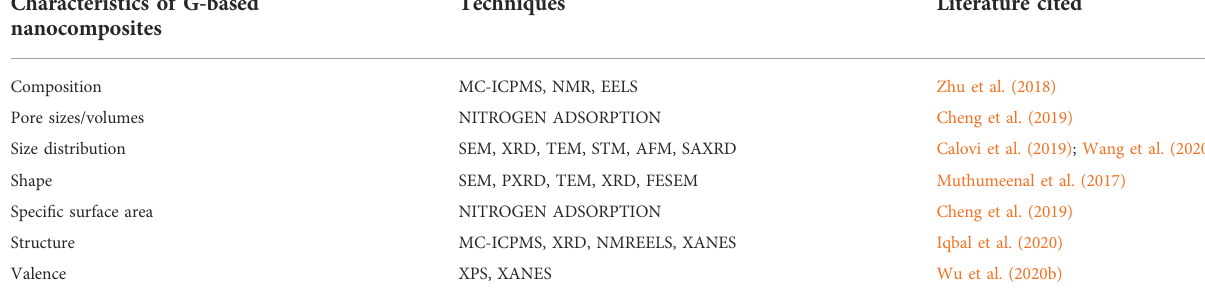
TABLE 1 Graphene-based nanocomposites: characterization